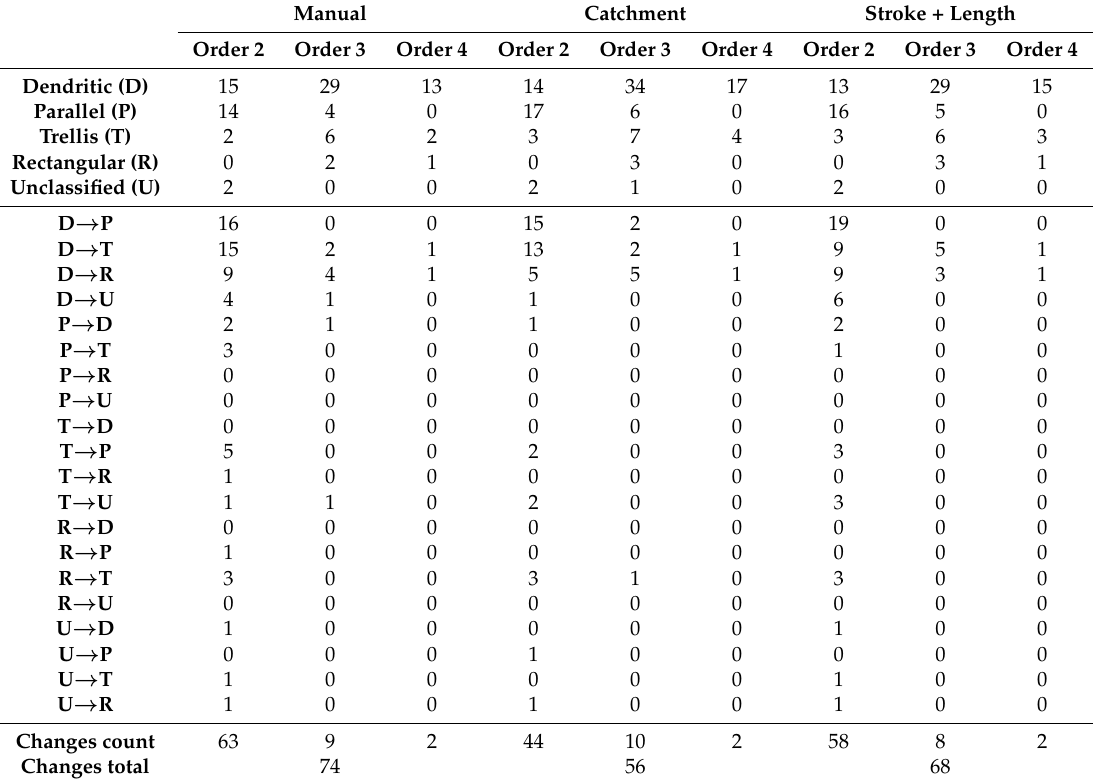
Table 10. Number of drainage patterns after generalization. “ → ” means that one pattern changes to another. The order is the Horton-Strahler ordering scheme.